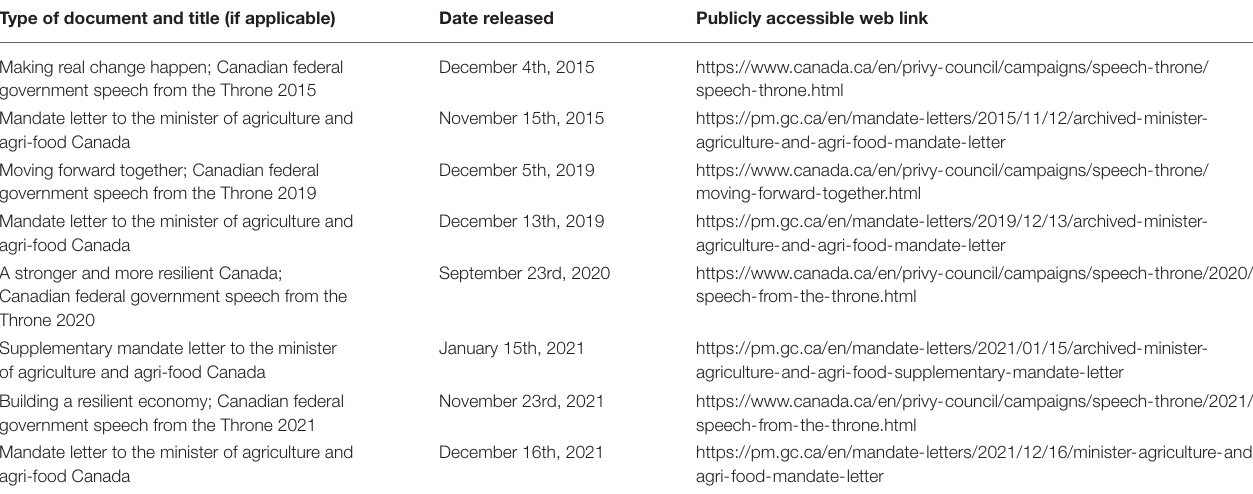
TABLE 1 | Documents used for the analysis of federal narratives and food systems commitments from 2015 to